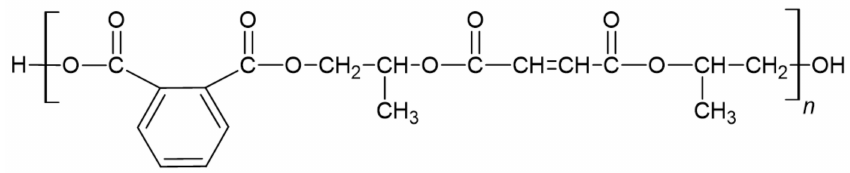
Figure 19. The structure of orthophthalic UPR [83].